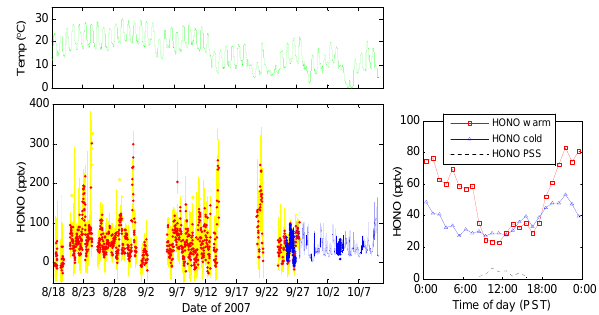
Fig. 7. Left: time series of measured HONO mixing ratios by CIMS (1min averages in yellow and 10min averages in red) and by wet chemistry (in blue) and temperature (in green). The integration time is 2min for the wet chemistry HONO instrument. The integration time is 0.5s every 18s and 1-min averages are shown in this figure. Right: diurnal variations of HONO mixing ratio during the warm period (red squares) and cool period (blue triangles). Also plotted are the photo-steady state (PSS) HONO mixing ratios (dashed black line) averaged for the entire study. In the PSS calculation, only gas phase HONO sources are included during the day between 08:00 and 16:00